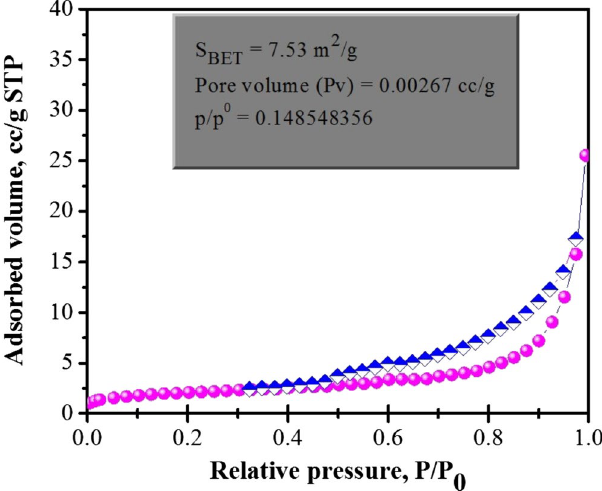
Figure 6. Nitrogen adsorption (magenta circles) and desorption (blue diamonds) isotherms of fly ash.